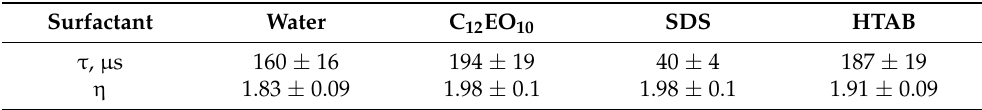
Table 2. The lifetime and the fluorescence efficiency of the Tb(Phen)-AA complex in microheteroge- neous media ( λ = 545 nm, transition 5 D 4 → 7 F 5 ).